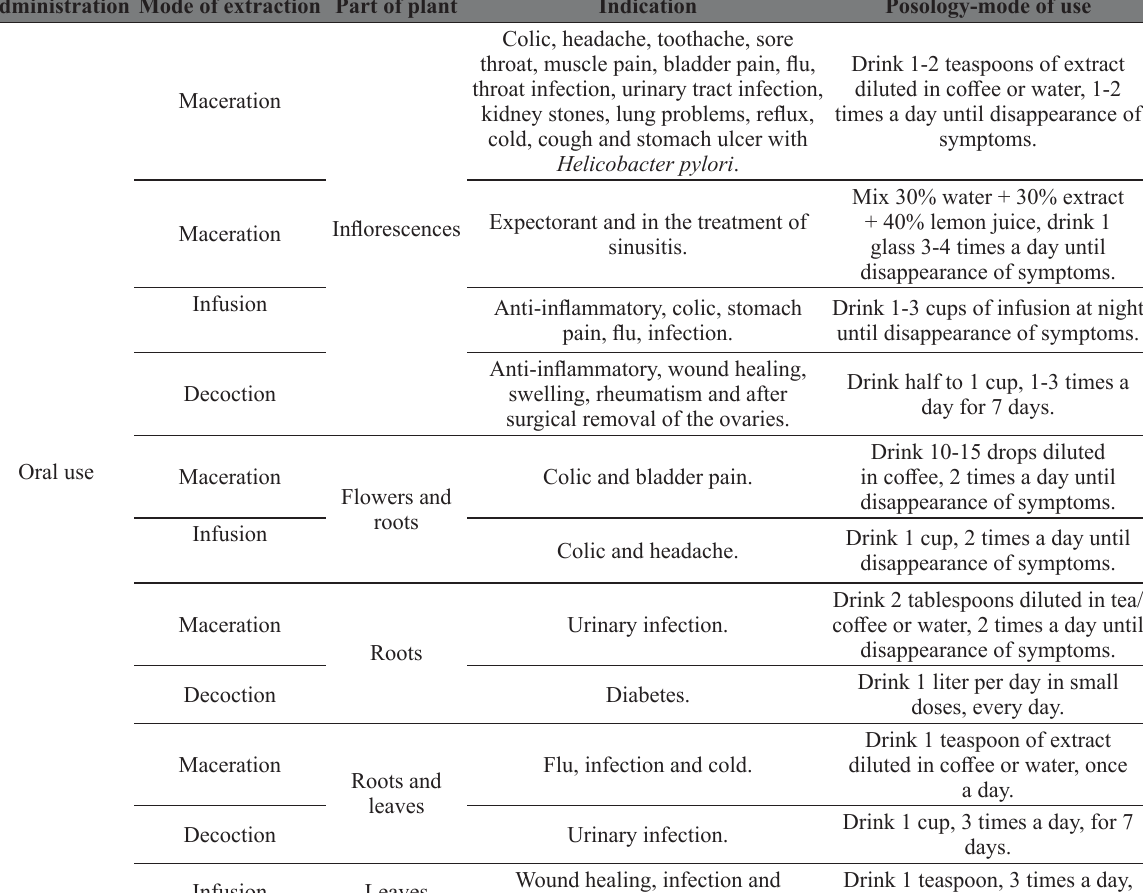
indications for popular use orally, otologically and via inhalation of C. uniflora. Administration mode of extraction Part of